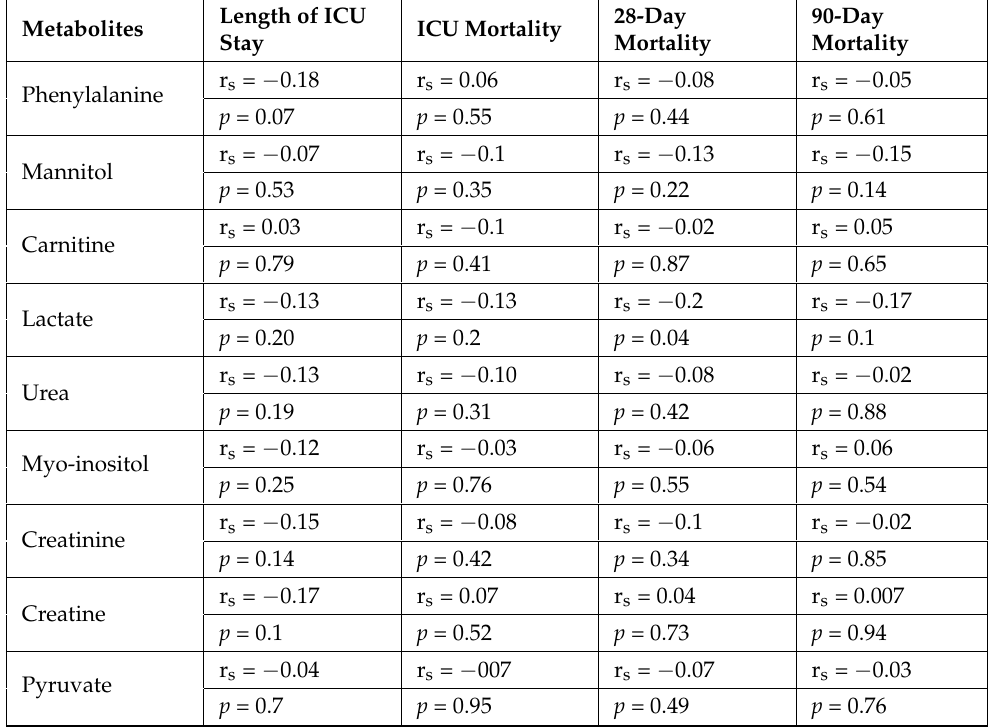
Table 6. Correlations between metabolites, length of ICU stay and